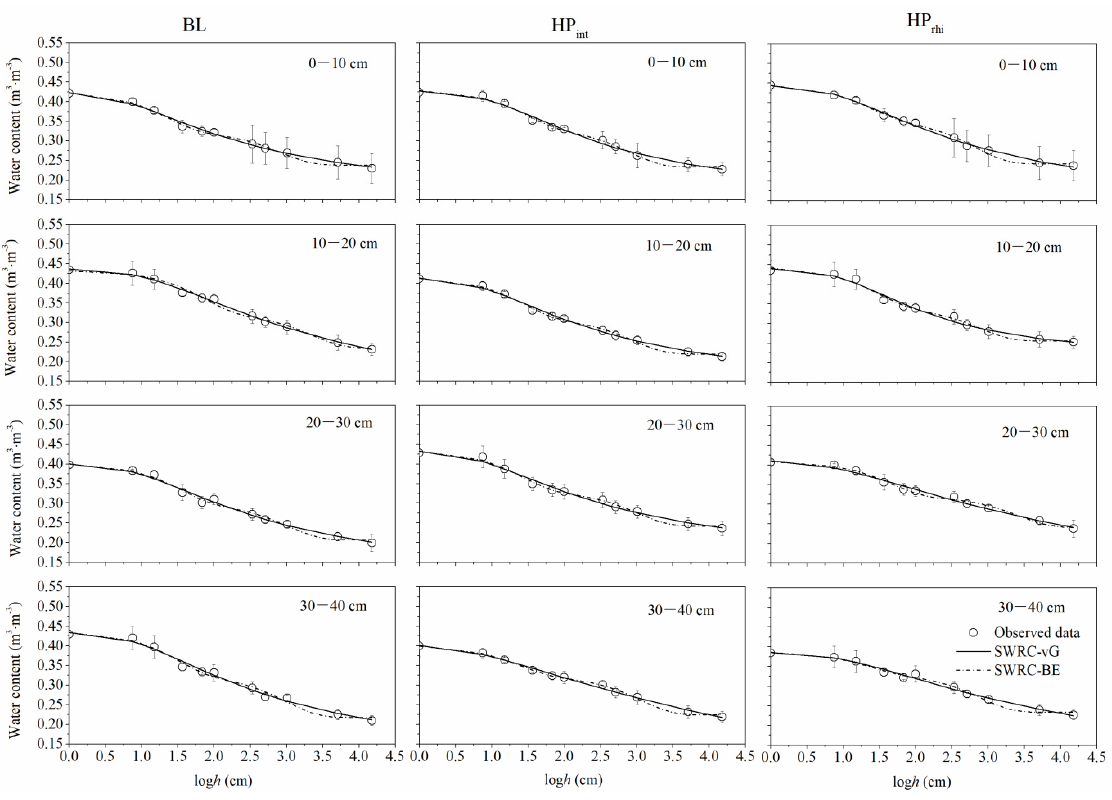
Figure 3. Comparison of soil water retention curves obtained by fitting the single porosity van Genuchten (1980) model (SWRCvG) and biexponential model (SWRCBE) to water content data measured on soil core samples collected from plot BL, inter-row location (HP int ), and honeysuckle planted location (HP rhi ) of plot HP.